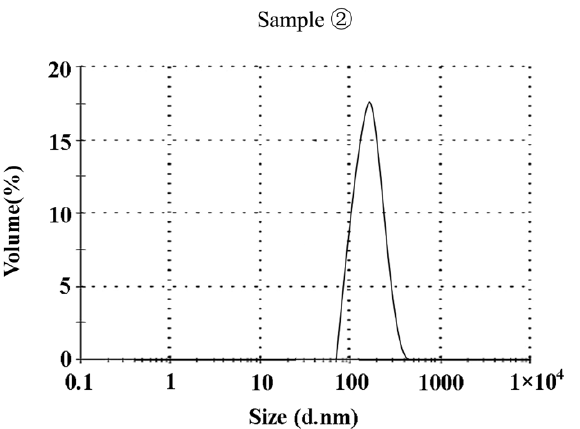
Figure 3. The particle size distribution of the system when the molar ratio of epoxy groups is E51:ED = 3:1.